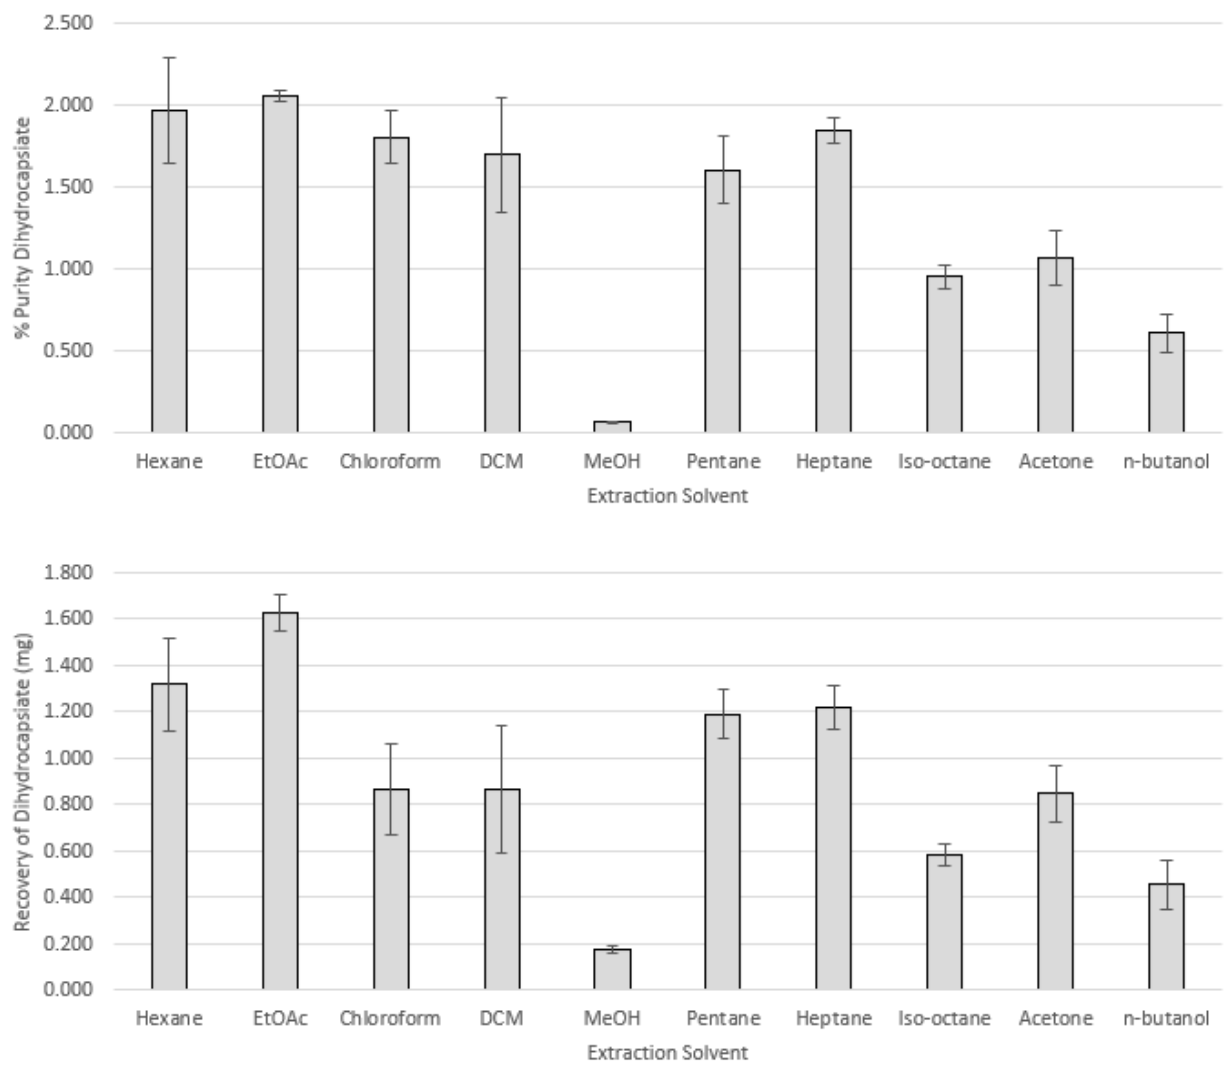
Figure 3. Extraction efficiency of solvents on the purity and recovery of dihydrocapsiate from dried fruit of Capsicum annuum (509-45-1). Table 2. Capsinoid percent purity in the bulk liquid/liquid extraction experiment using pen-